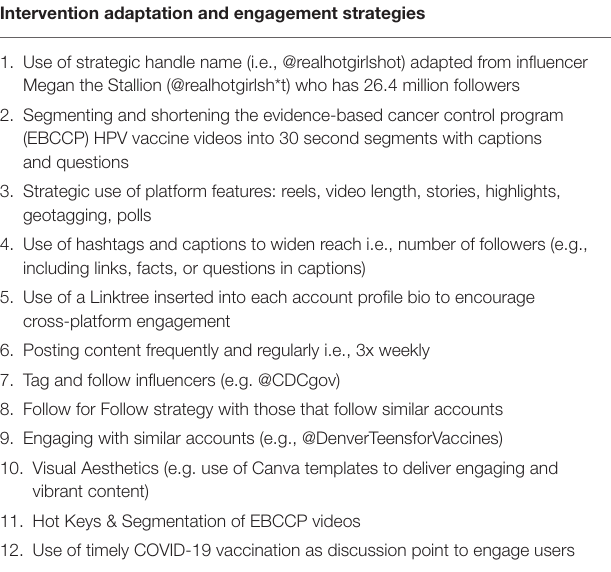
TABLE 1 | Social media engagement strategies employed across 4